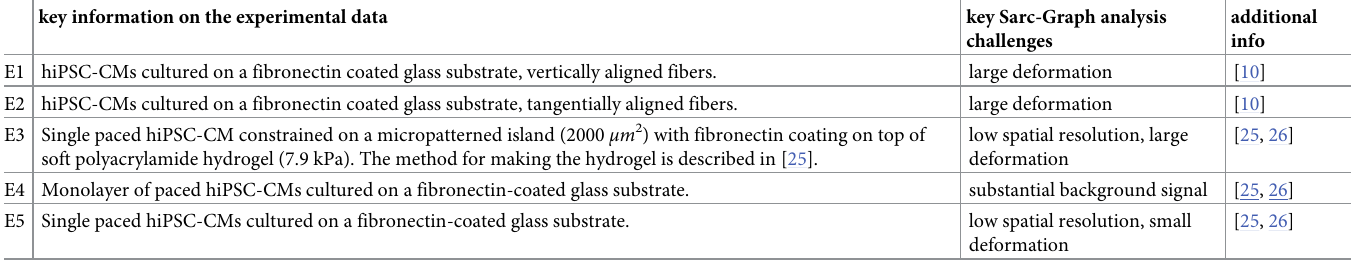
Table 1. Summary of experimental examples included in this paper (E1, E2, E3, E4, and E5). We note that Examples E1 and E2 have already been published and made publicly available at https://github.com/HMS-IDAC/SarcTrack [10]. key information on the experimental data key Sarc-Graph analysis